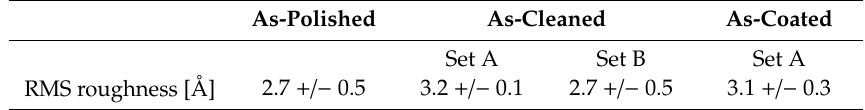
Figure 4. Typical picture of an as-cleaned uncoated sample after laser damage testing.